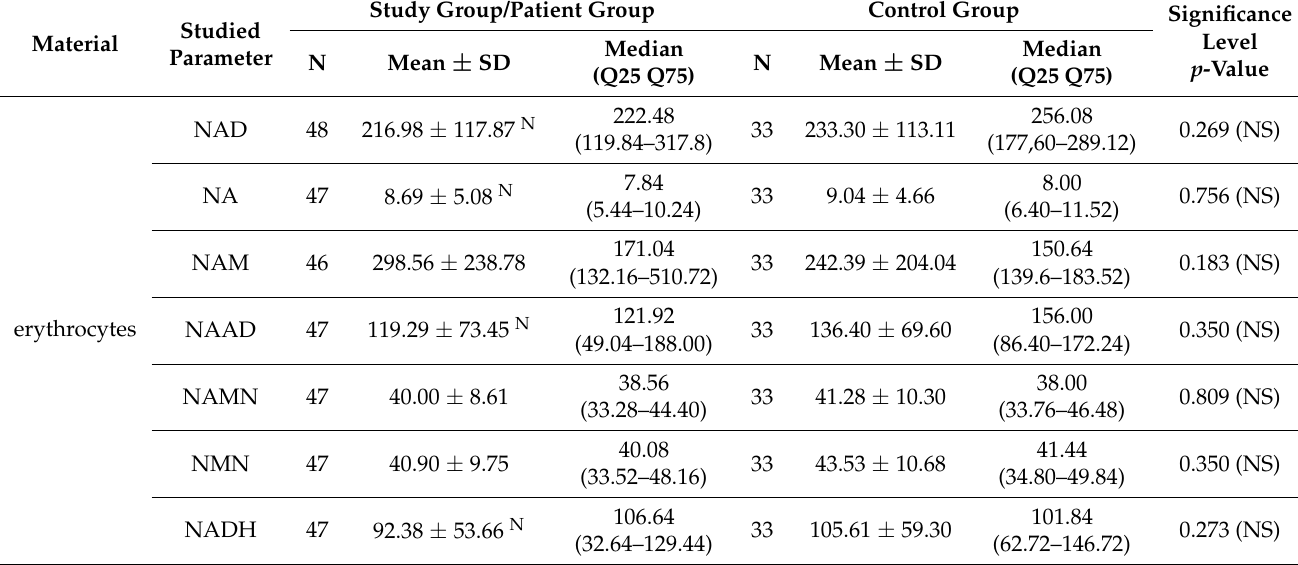
Table 3. Comparison of test results for both study and control group (N =